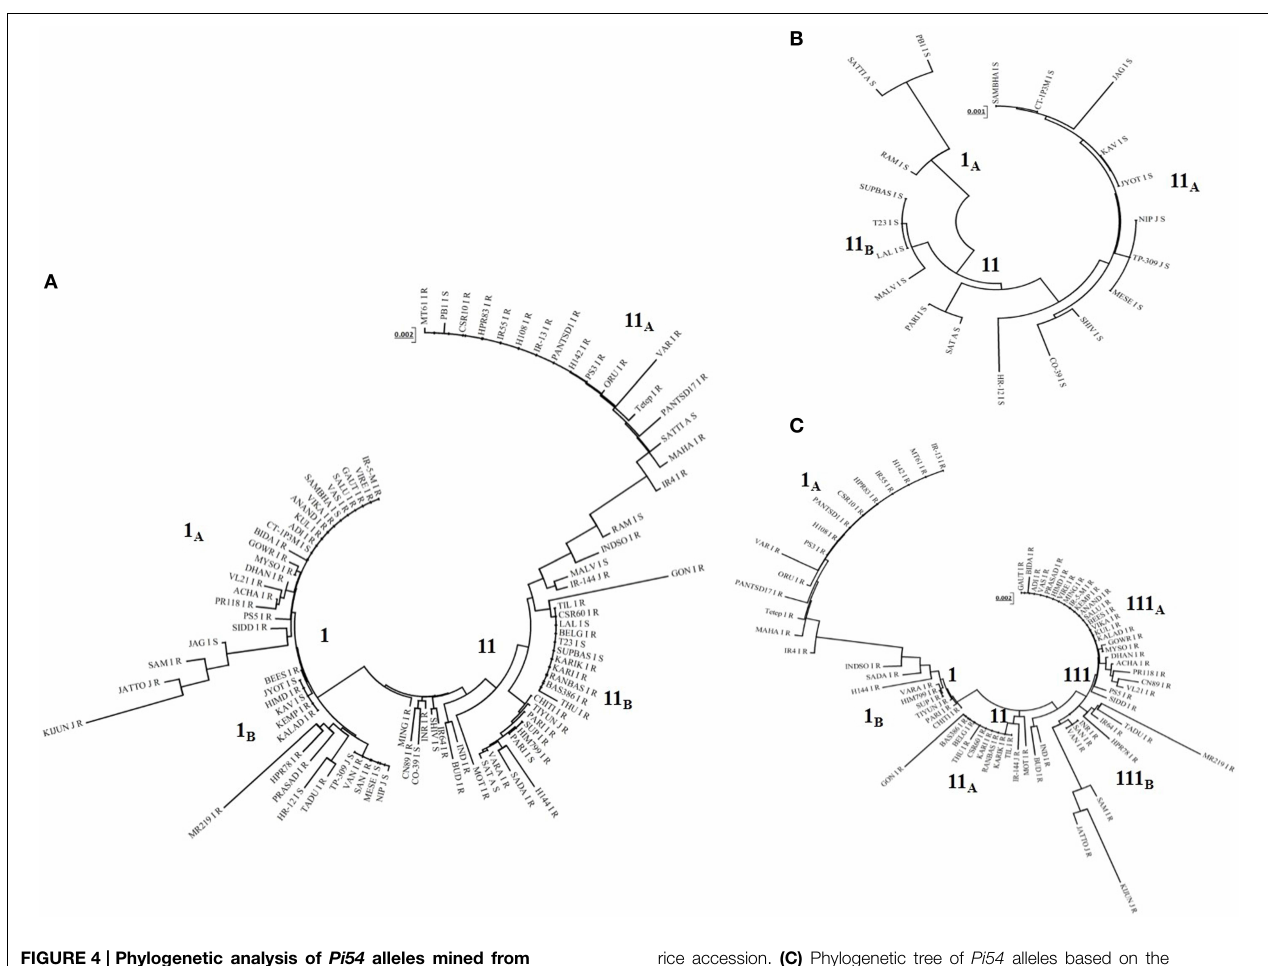
rice accession. (C) Phylogenetic tree of Pi54 alleles based on the nucleotide sequences of 72 blast resistant accessions. N-J method was used for the construction of tree. No definite clustering was obtained in all the